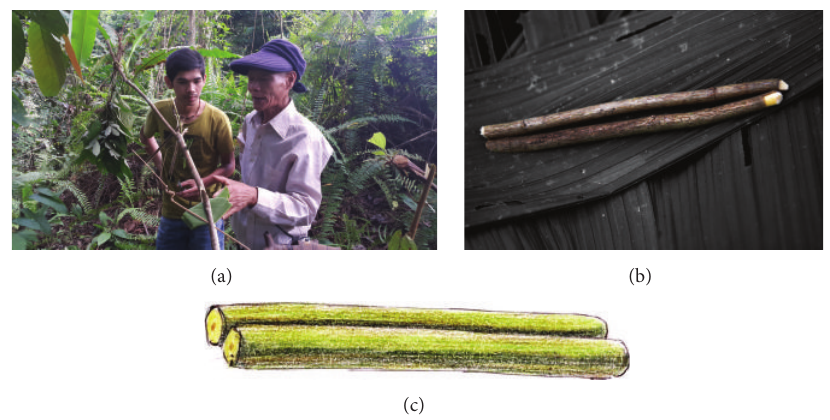
Figure 4: (a) Forest visit guided by Oroo’ expert. (b) Photo of Oroo’ sign. (c) Drawing of Oroo’ sign.